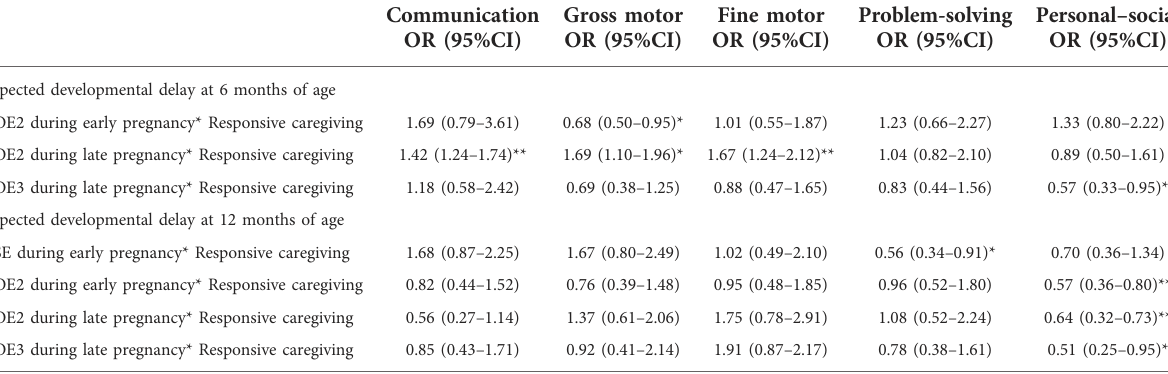
TABLE 4 Multivariate logistic model of maternal psychological stress associations with infant development vis-à-vis the interactions between maternal stress and responsive caregiving at 2 months of age (model II). Communication Gross motor